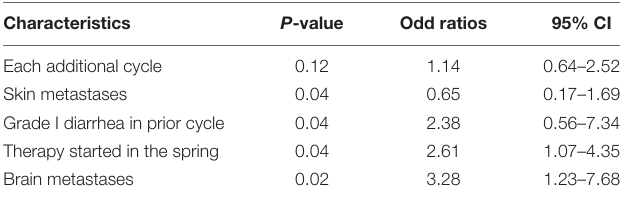
TABLE 5 | Multivariate model analysis of the risks associated with diarrhea incidences. Characteristics